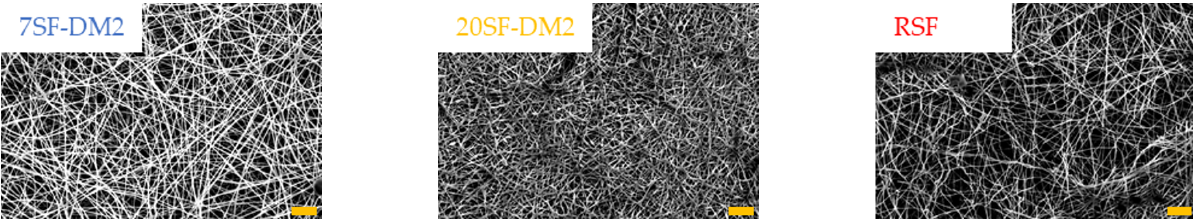
Figure 5. SEM images of electrospun nanofiber nonwoven mat from fractionated SF. Scale bar = 10 µ m.